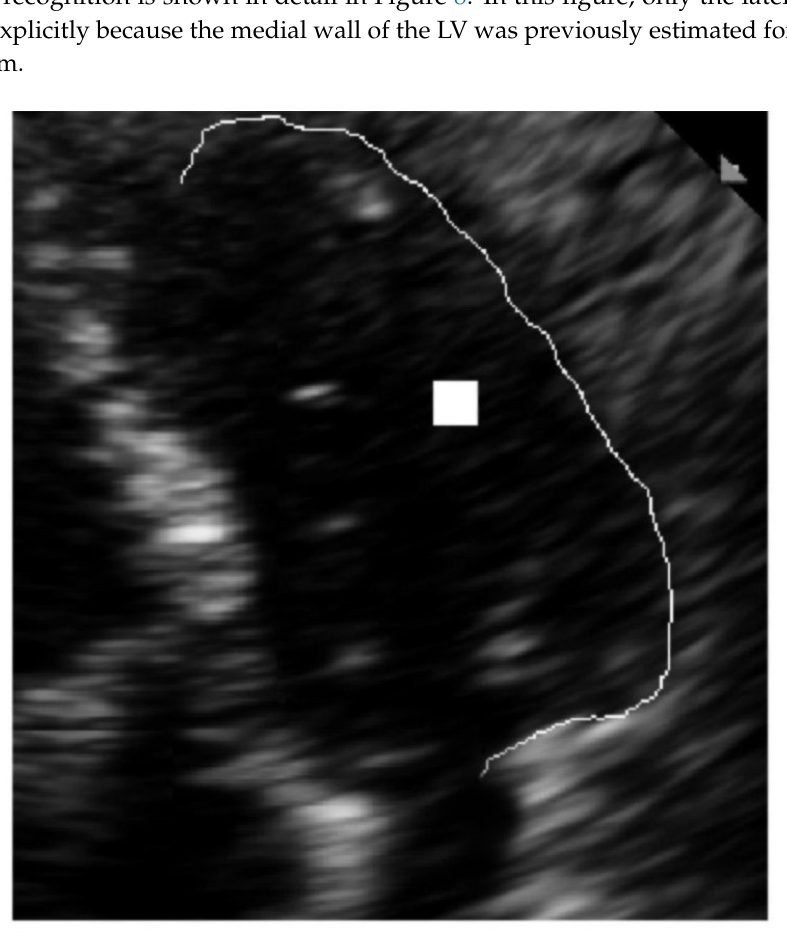
Figure 8. Recognition of the lateral wall of the LV in